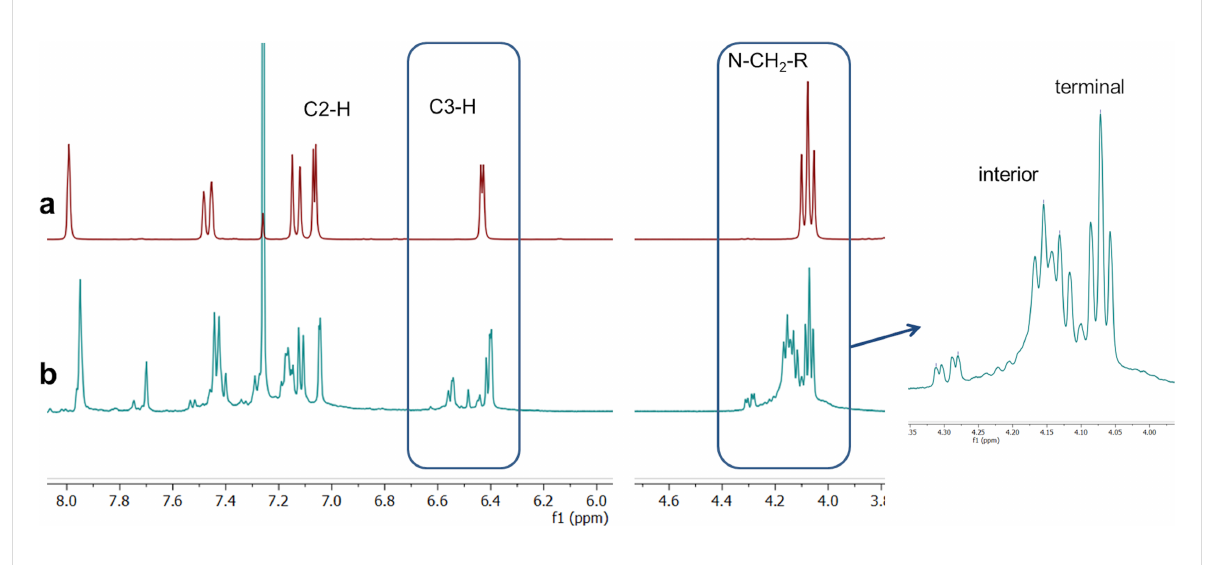
Figure 1: 1 H NMR (500 MHz, CDCl 3 ) of (a) 5-iodo-1-octylindole monomer (b) PIn prepared according to conditions in Scheme 1. The region from 4–4.5 ppm indicates the interior indole repeat units compared with the terminal indole units.